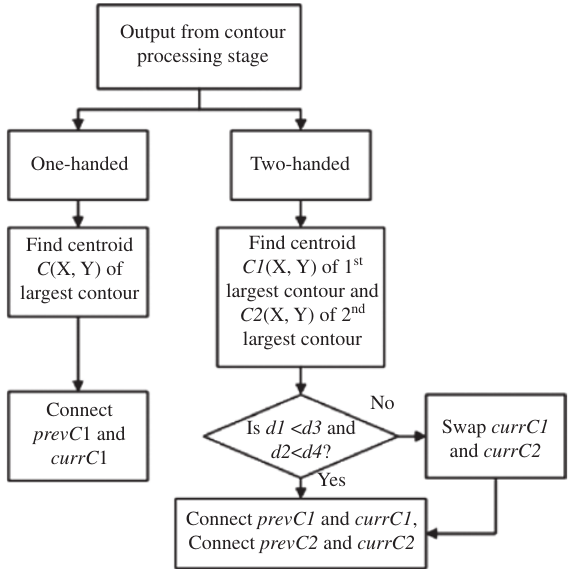
Figure 3: Flowchart of the Hand Tracking